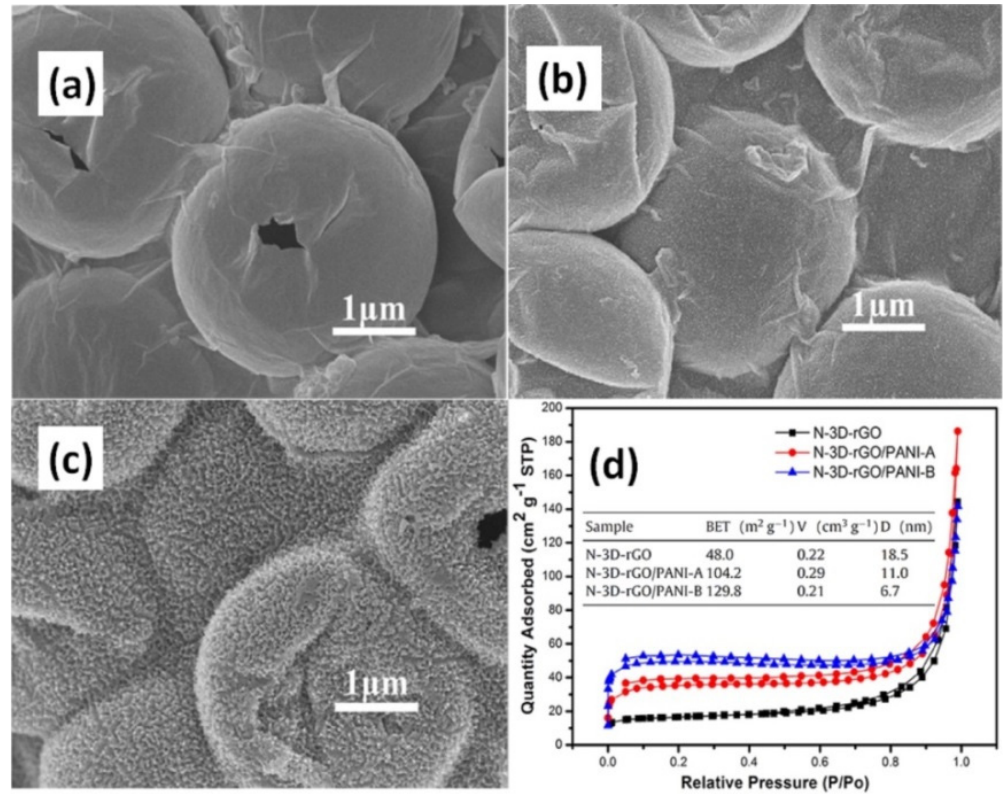
Figure 8. SEM images of N-3D-RGO ( a ), N-3D-RGO/PANI-A ( b ) (prepared with APS), N-3D- RGO/PANI-B ( c ) (prepared with β -MnO 2 ), and their nitrogen adsorption/desorption isotherms (insert: BET surface area, pore volume ( V ), and pore diameter ( D ) ( d ) (Reprinted from [96], Copyright 2017, with permission from